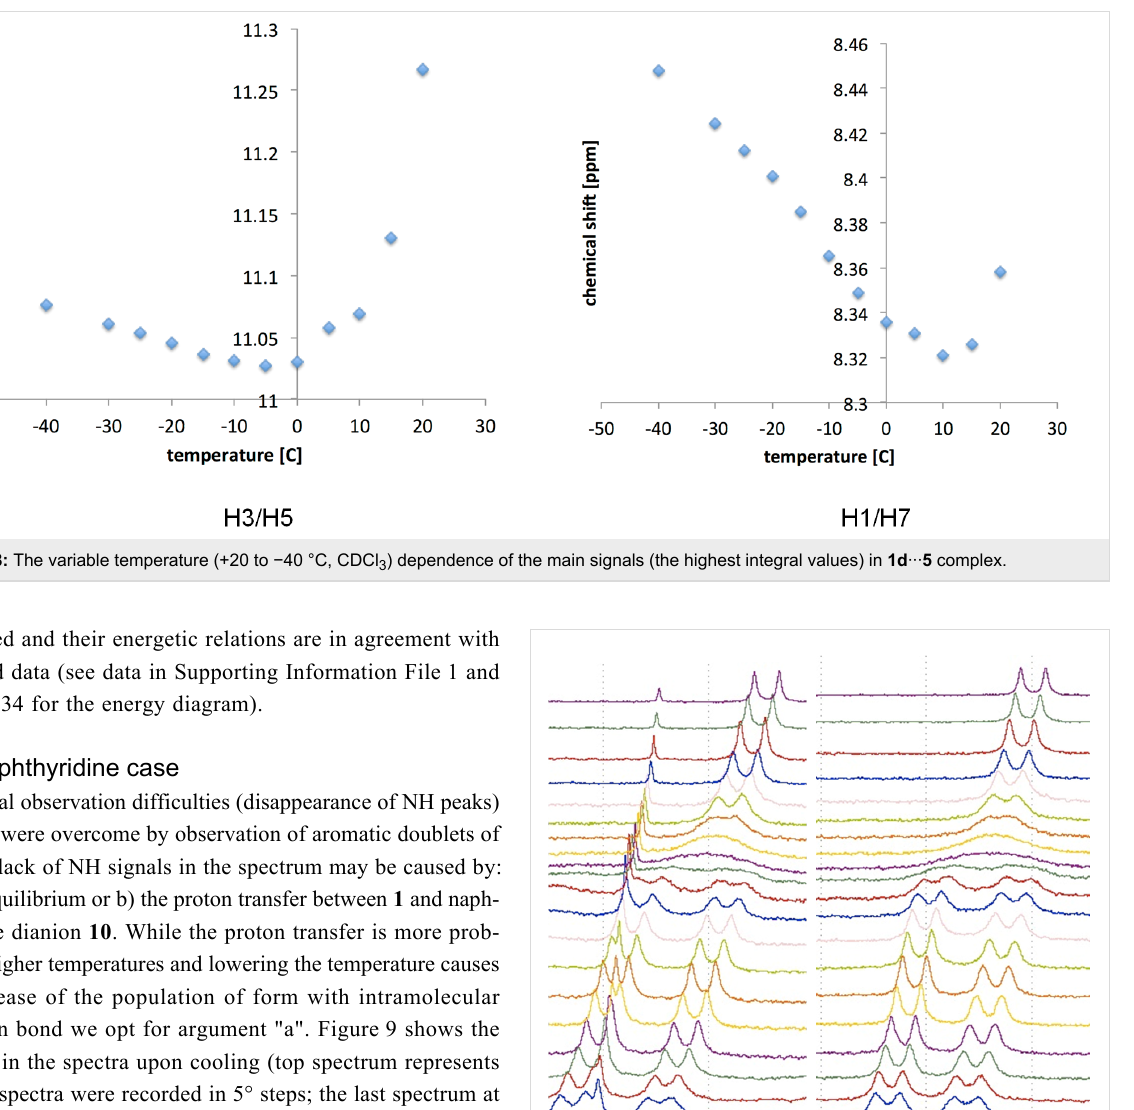
Figure 9: The VT (+20 to − 70 °C, CDCl 3 ) 1 H NMR stacked spectra (low temp. at bottom) for 1 ∙∙∙ 10 in 1:0.1 molar ratio (on the left spec- trum a small satellite signal from residual chloroform is